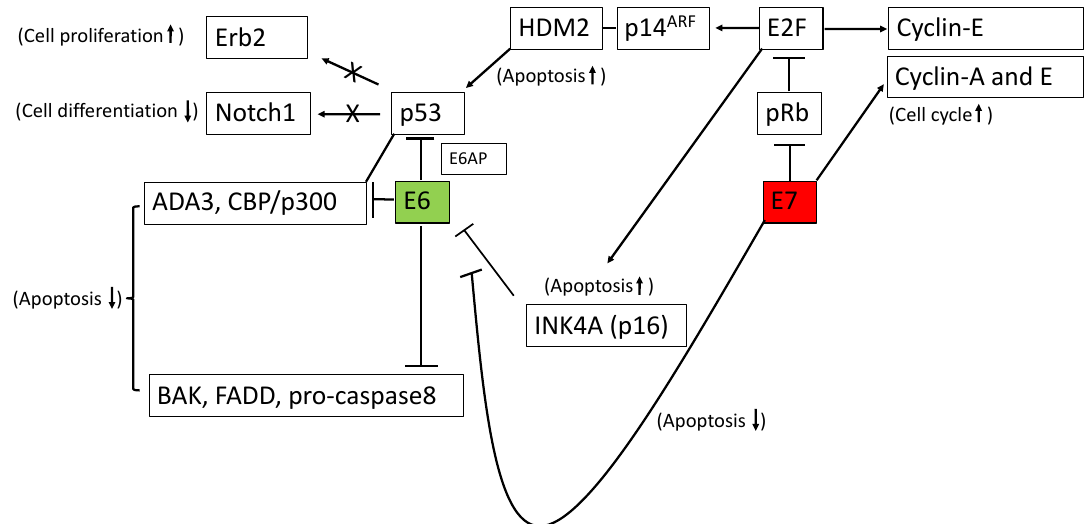
Figure 1 . Synergistic functions of E6 and E7 oncoproteins. E6 induces the ubiquitin-dependent proteosomal degradation of p53 by forming a complex with E6 and E6-associated protein (E6AP), resulting in the inhibition of Notch1 and Erb2 expressions. E6 also inhibits transcriptional conjugating factors of p53 such as CBP / p300 and ADA3, and apoptosis-inducing factors such as BAK, far-associated protein with death domain (FADD), and pro-caspase8. E7 inhibits RB, which releases E2F. E2F induces the expression of cyclin-A and E, resulting in cell proliferation. E2F also induces the expression of p14ARF. The complex with p14ARF and human double minute2 (HDM2) represses the p53 degradation, resulting in inducing p53-dependent apoptosis. E7 also inactivates INK4A and rescues E6 from inhibition by INK4A. Up and down arrows, up and down regulation, respectively.